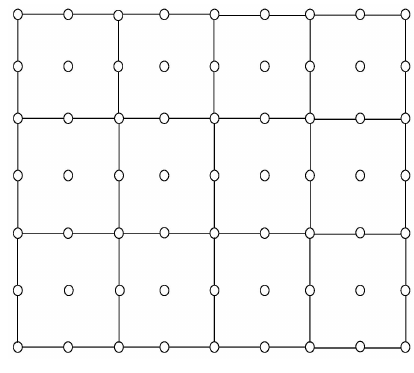
Figure 9. Grid point map.